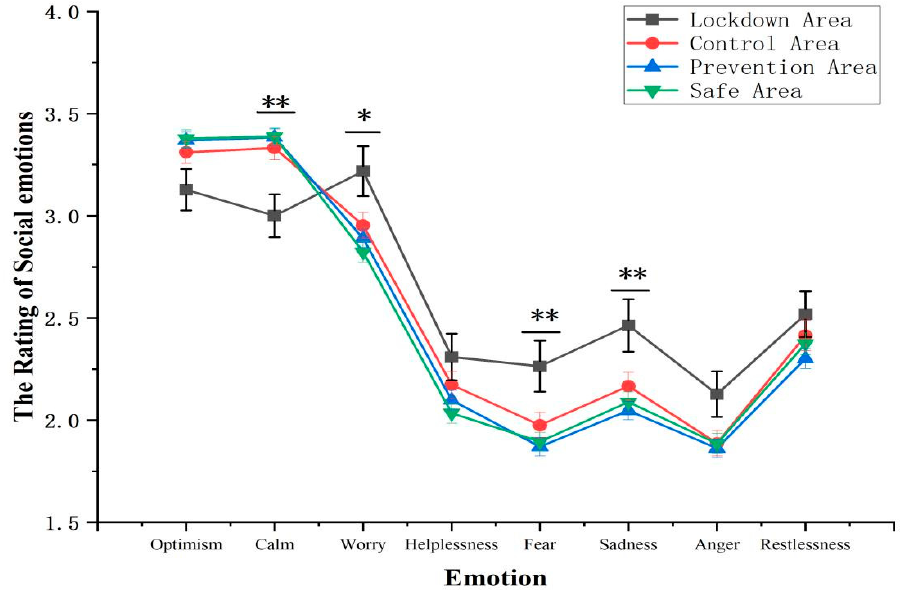
Figure 1. Social emotions in different areas. * p < 0.05, ** p < 0.01.